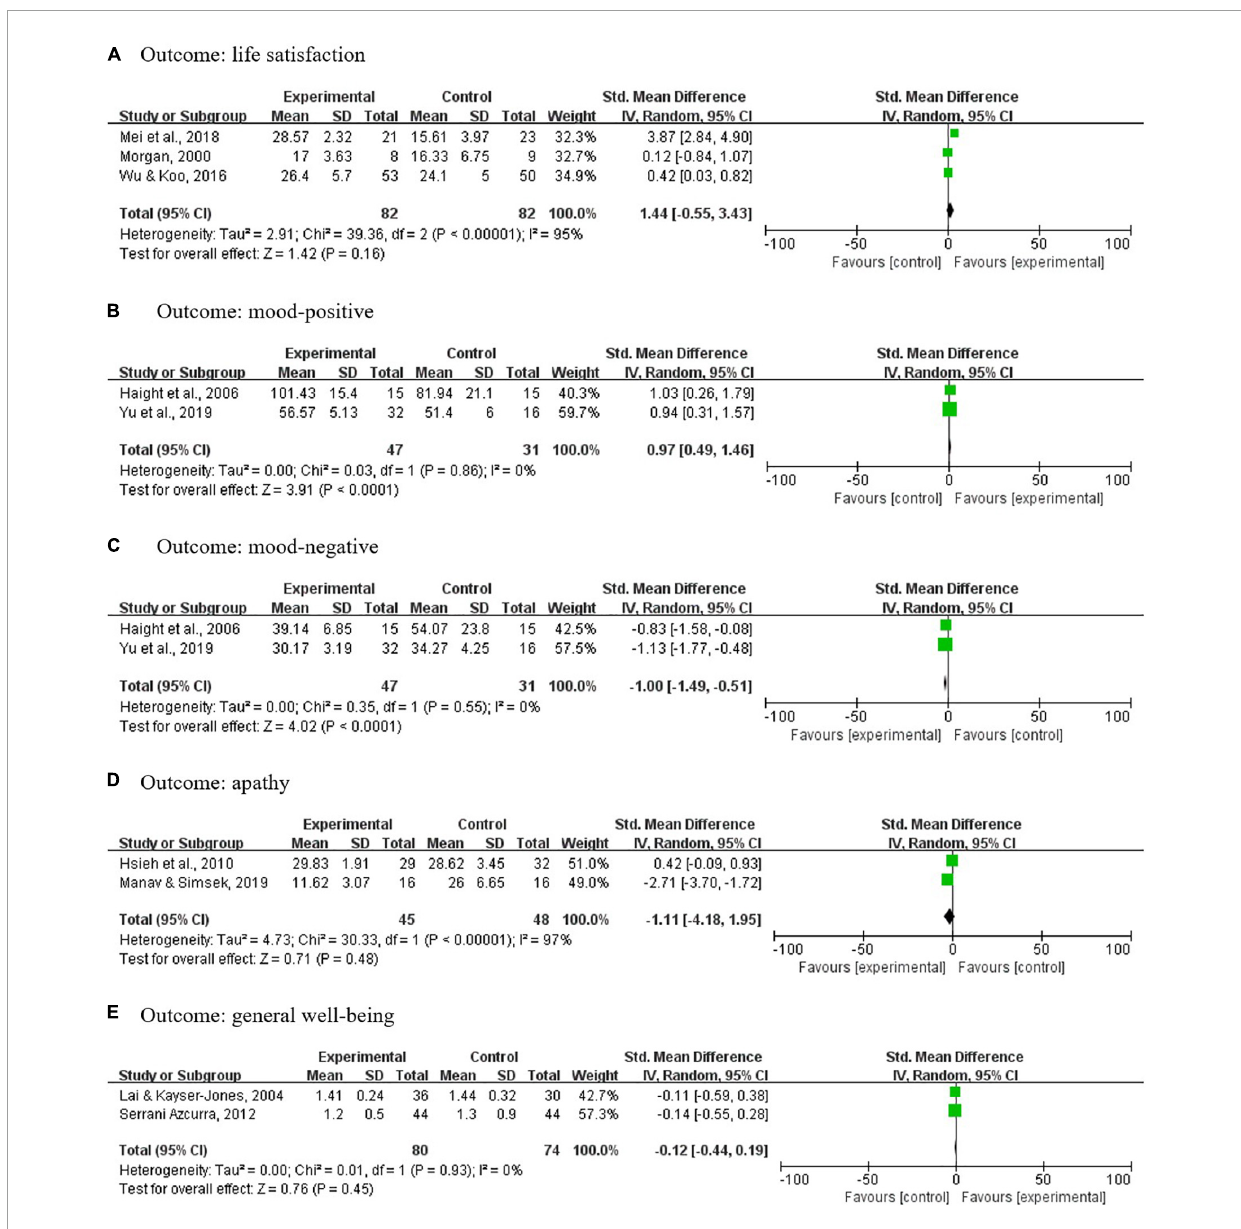
FIGURE6 Meta-analyses results on life satisfaction, mood, apathy, and general